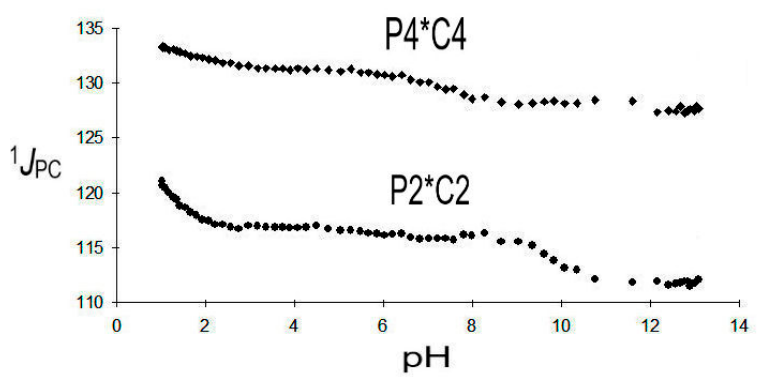
Figure 6. 1 J PC (P2*C2) and 1 J PC (P4*C4) of DPBDC 9 .